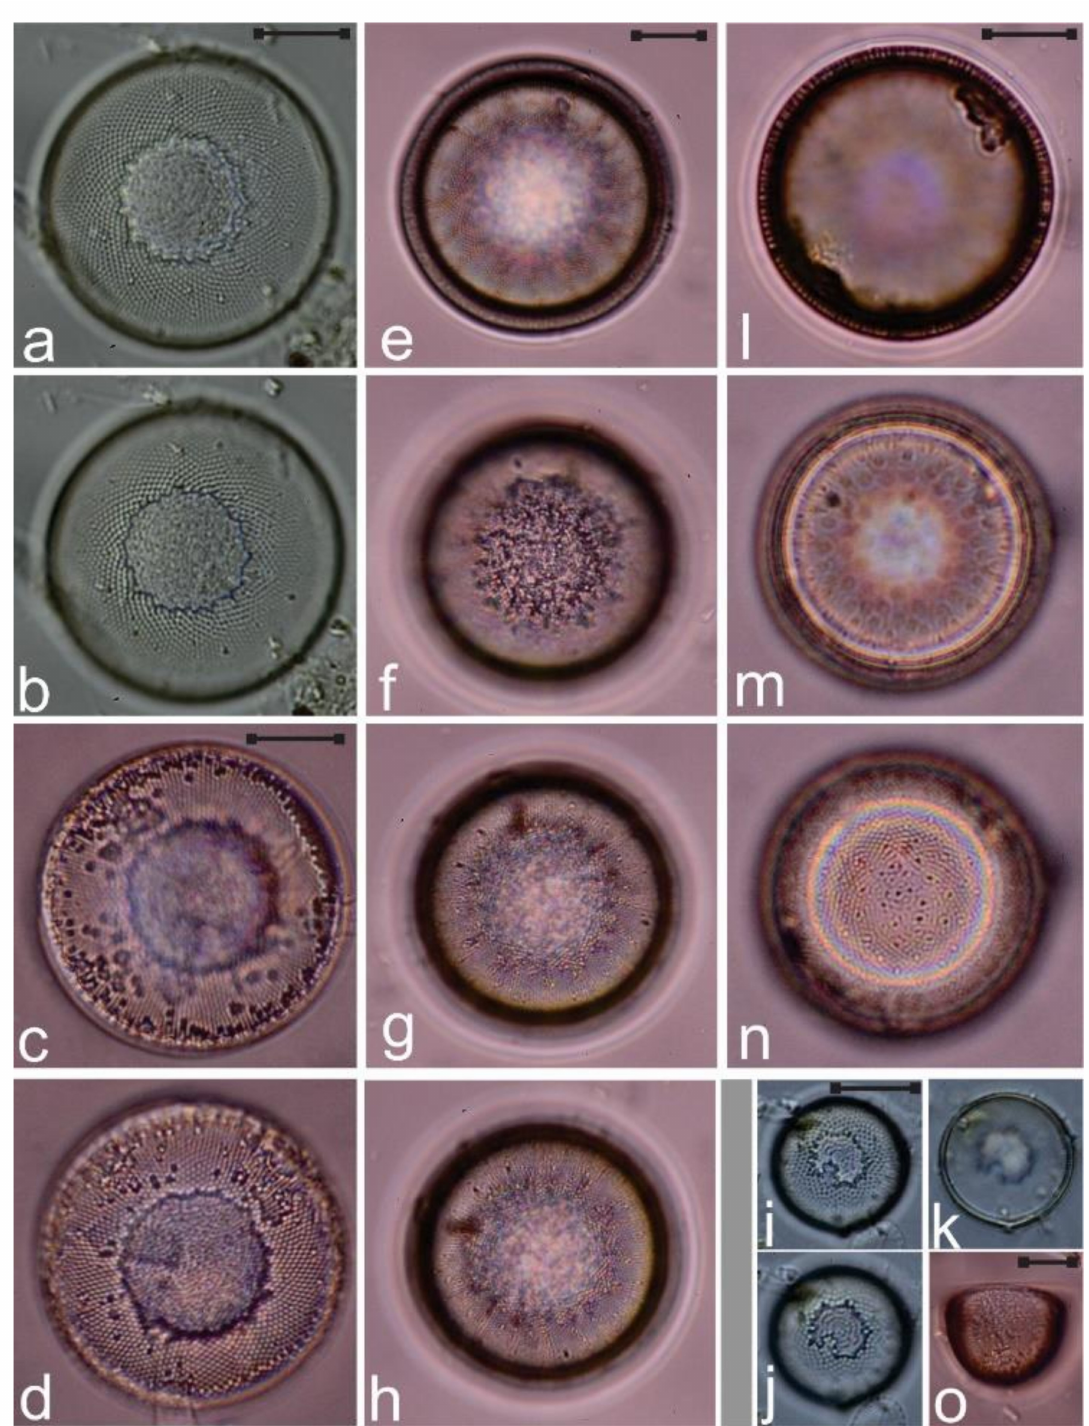
Figure 8. ( a – k ) Podosira stelligera in di ff erent focal planes and showing range in size; ( l – n ) P. variegata in di ff erent focal planes; ( o ) P. montagnei valve in girdle view. Scale bar = 10 µ